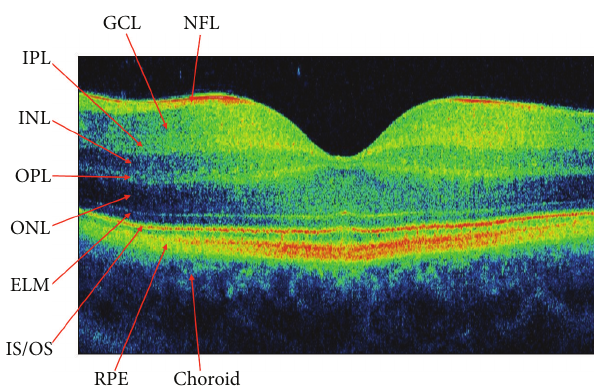
Figure1:SDOCTcross-sectionalimageofanormalhumanmacula. NFL: nerve fibre layer, GCL: ganglion cell layer, IPL: inner plexiform layer, INL: inner nuclear layer, OPL: outer plexiform layer, ONL: outer nuclear layer, ELM: external limiting membrane, IS/OS: the junction between the inner and outer photoreceptor segments, RPE: retinal pigment